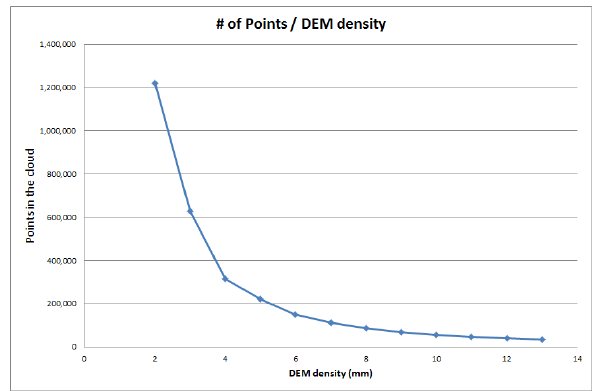
Figure 7. Number of points in the cloud as function of DEM